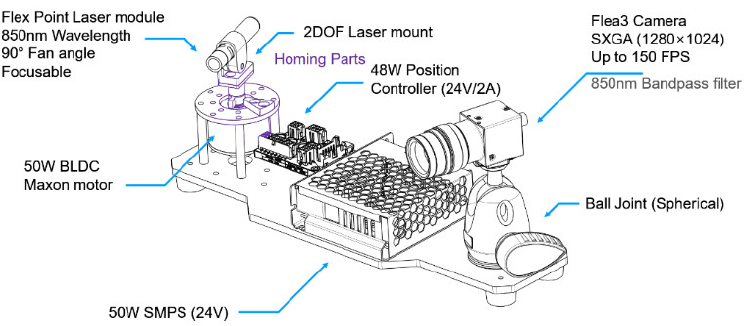
Figure 2. Scanning system with a line laser fixed to a motor and infrared camera.